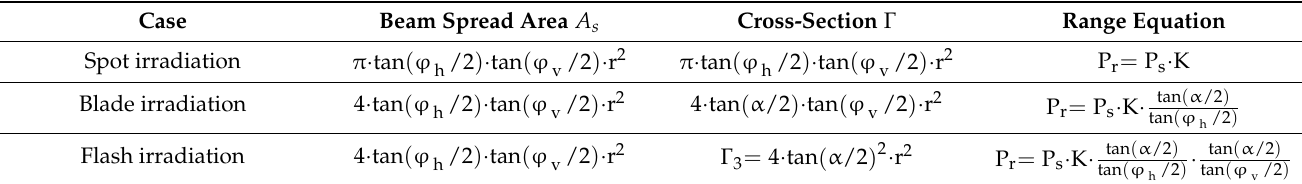
Table 2. Range equations concerning a single pixel for various radiation